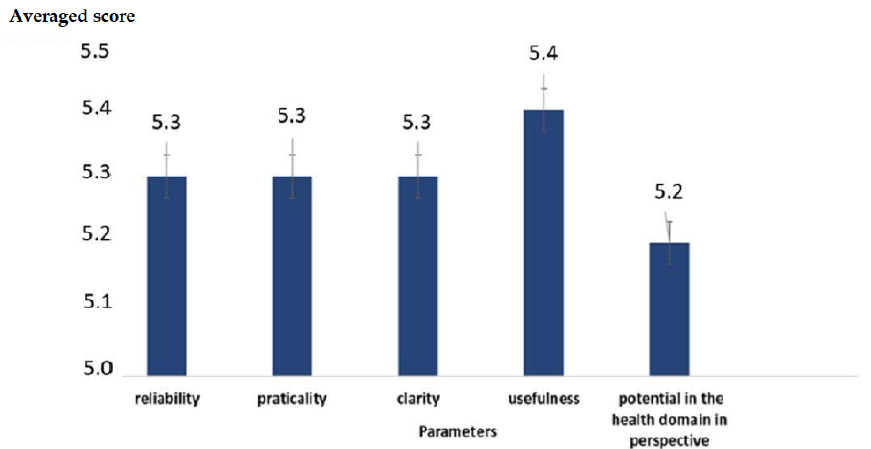
Figure 4. Averaged score for the different parameters proposed to assess the opinion of the participants. The best six were selected based on a ranking considering both impact and